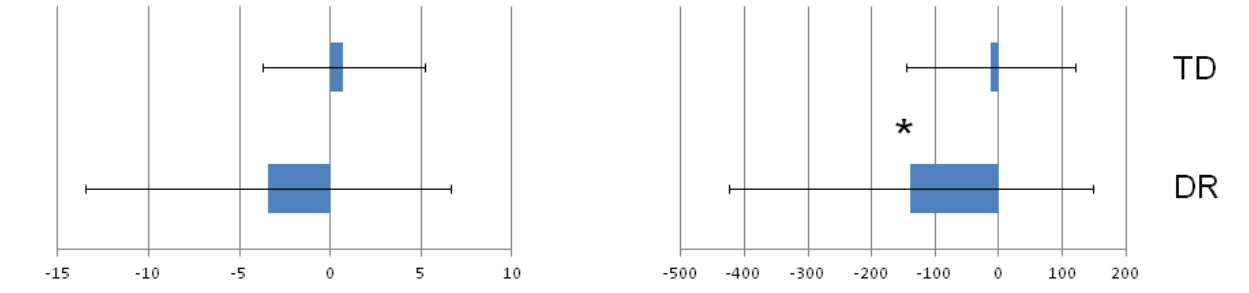
Figure 3. Estimation error (EE; median values represented by bars) obtained in the DR and TD groups in the verbal task with the use of 0–100 number line ( left ) and 0–1000 number line ( right ). The error bars represent the interquartile range (IQR) values. * p < 0.05. Table 1. Descriptive statistics (median, IQR, and range) calculated for all numbers used in tasks 1 and 2 (0–100 and 0–1000, respectively) obtained in the DR and TD groups.